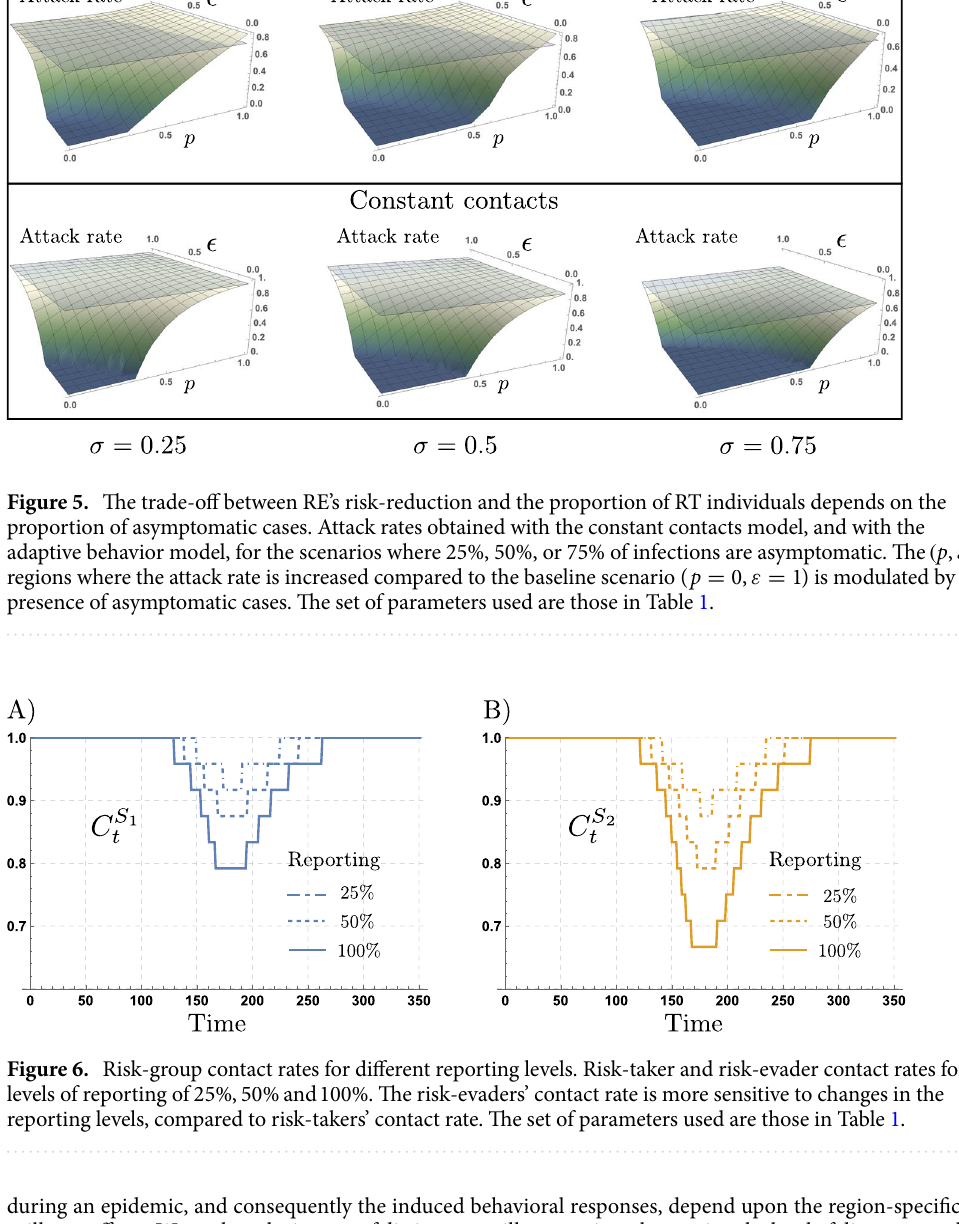
during an epidemic, and consequently the induced behavioral responses, depend upon the region-specific sur- veillance efforts. We explore the impact of distinct surveillance regimes by varying the level of disease prevalence observed through testing. This is incorporated in our behavior model, by including the scalar factor 0 ≤ ϕ ≤ 1 in the incidence terms of Eq. (1). In this way, the surveillance level modifies the perceived probability of infec- tion in the Bellman’s equations by only perceiving a fraction of the infectious population, ultimately affecting the behavioral decision chosen. In most countries, reporting is biased towards the identification of symptomatic individuals 58 . For simplicity, in our model we assume reporting impacts the perceived infection risk by reducing the overall perceived disease prevalence level. We incorporate a scalar factor that modulates the perceived infec- tious subpopulations (exposed, symptomatic and asymptomatic), proportional to its size. In other words, we do not incorporate the bias produced by mostly reporting symptomatic individuals. Figure 6 shows the impact of different levels of reporting on the contact rates of the risk-takers and risk-evaders. Our simulations show that behavioral responses of both risk-groups are highly sensitive to changes in reporting levels. Moreover, risk- evaders’ behavioral responses dramatically reduce as the level of reporting decreases. Our next simulations explore the effects of different reporting levels ( ϕ ) on the attack rate attained for the adaptive behavior model, for populations composed of different proportions of risk-takers ( p ). Figure 7 shows that for the adaptive behavior model, the impact of risk-takers on the attack rate depends upon the reporting levels. Particularly, the extent to which behavioral responses decrease the attack rate depends on the reporting levels. For high reporting levels ( ϕ ≈ 1 ), the attack rate shows a concave up shape to increments in the proportion